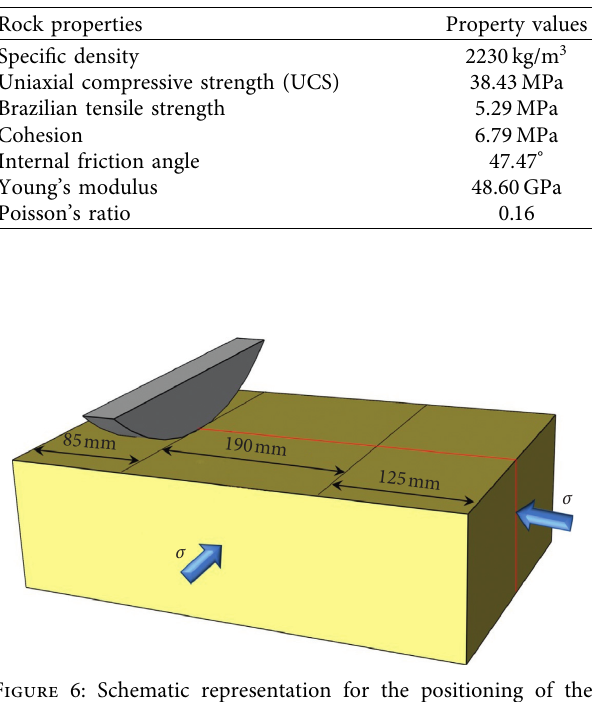
Table 1: Properties of the sandstone used in laboratory tests.